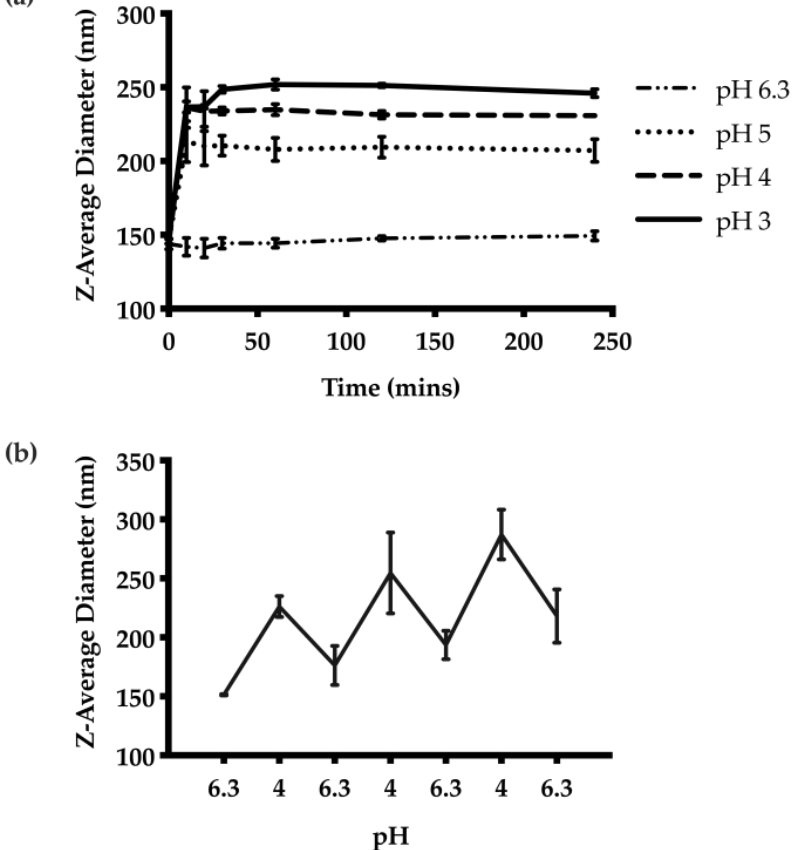
Figure 3. pH-responsive behaviour of the CNs: ( a ) Z-average diameters over time at different pH values from 3 to 6.3. The results suggest the degree of swelling is proportional to the acidity of the suspension. The swelling behaviour was also rapid, and reached equilibrium 10 min after pH adjustment. ( b ) The pH-responsive behaviour was further examined through pH cycling between pH 6.3 and 4. The nanoparticles were able to swell and contract accordingly based on the pH.